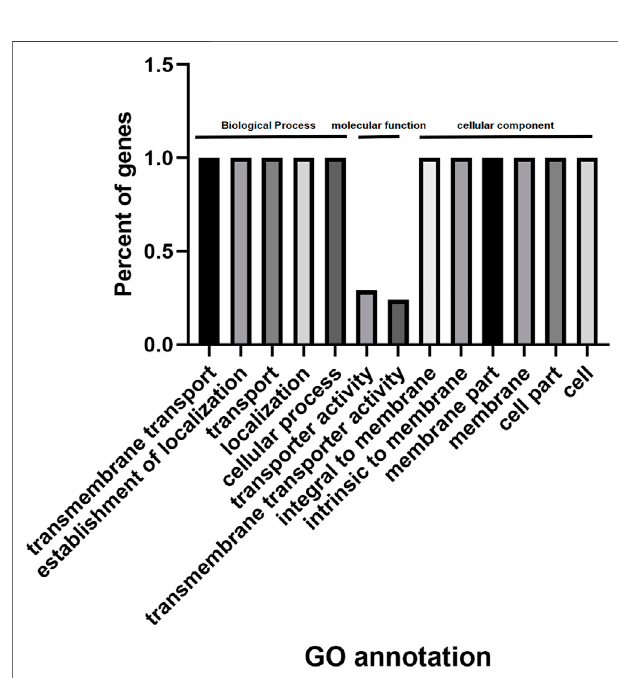
FIGURE 13 | GO analysis of PdpapMFS